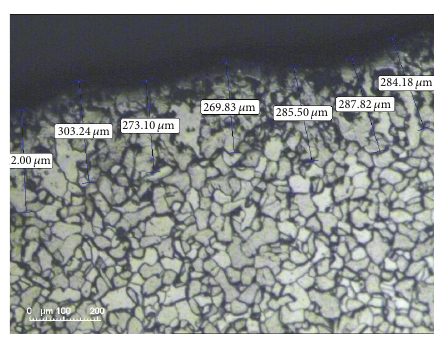
Figure 6: Measuring of HAZ depth.